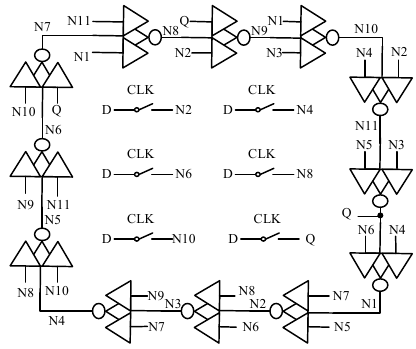
Figure 7. Latch schematic for LCTNURL.